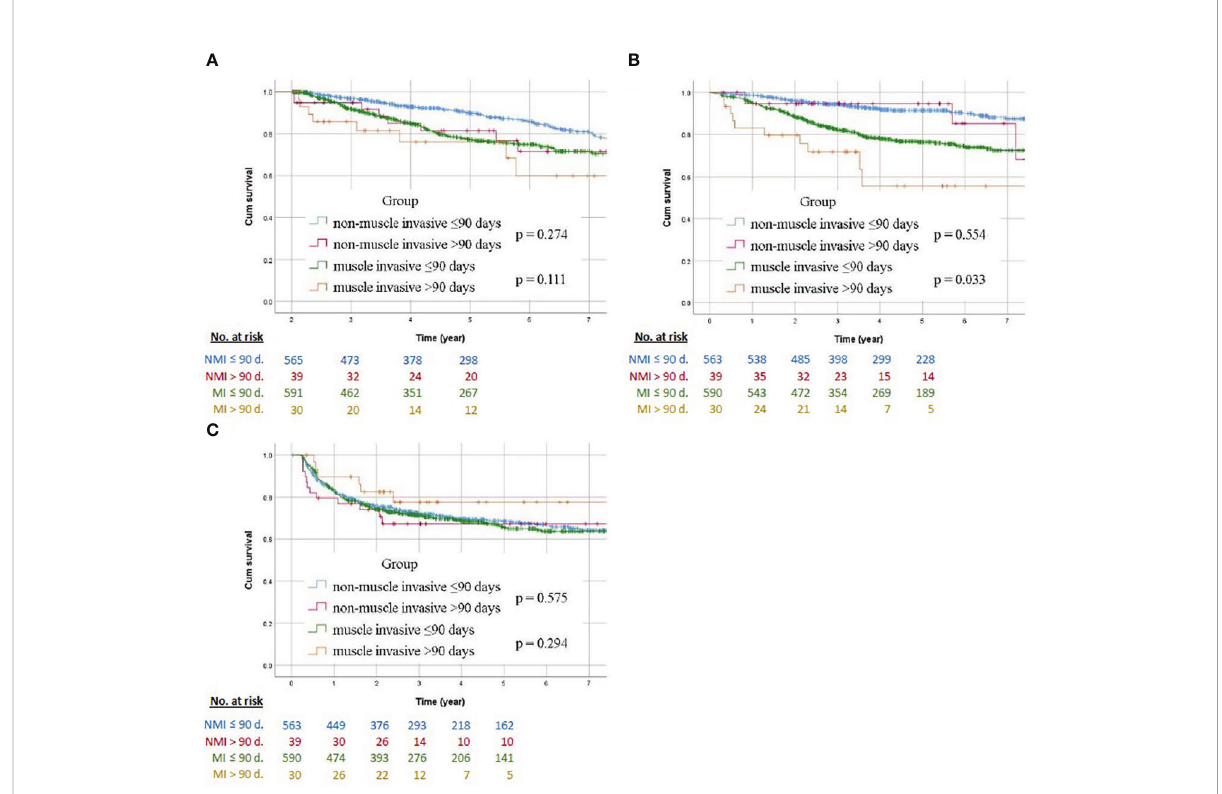
FIGURE 2 Survival Kaplan – Meier curves in patients with non-muscle invasive and muscle invasive UTUC comparing early and late surgical wait time to nephroureterectomy (A) overall survival, (B) disease-free survival, and (C) bladder recurrence-free survival. NMI, non-muscle invasive; MI, muscle invasive; d.,